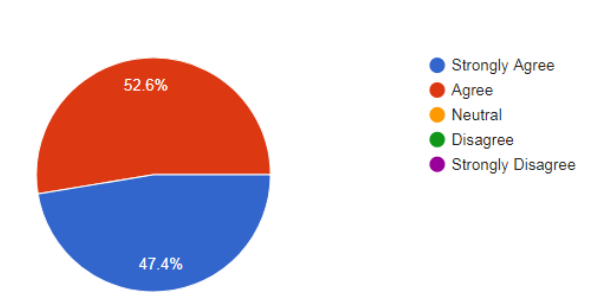
Figure 6: The Training would prove useful in future work